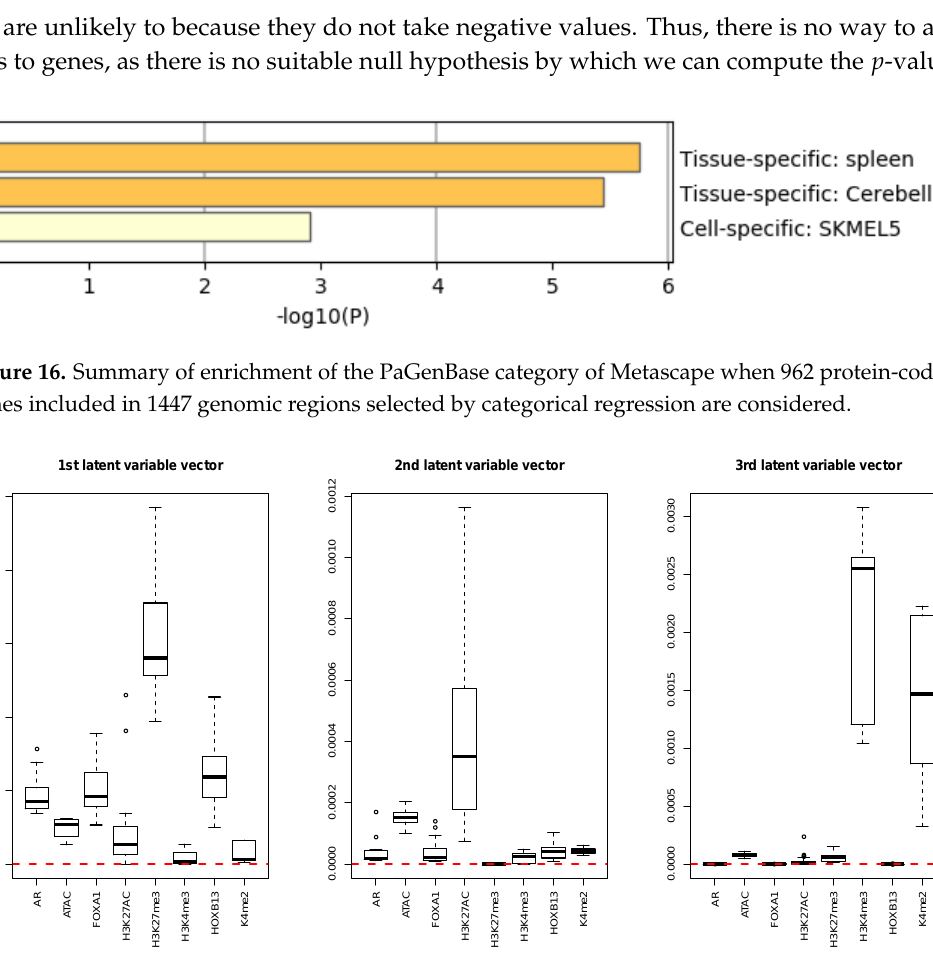
Figure 17. Boxplots of the first to third latent variable vectors attributed to 144 samples classified into eight subclasses, each of which corresponds to a multiomics measurement. The horizontal red broken lines are base lines (zero).